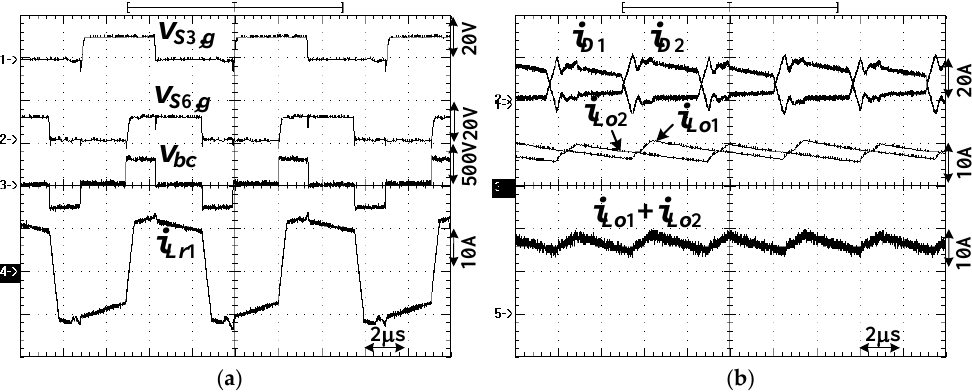
Figure 8. Test waveforms at V in = 290 V (low voltage input range) and P o = 800 W: ( a ) primary-side waveforms v S 3 ,g , v S 5 ,g , v bc , and i Lr 1 ; ( b ) secondary-side waveforms i D 1 , i D 2 , i Lo 1 , i Lo 2 , and i Lo 1 + i Lo 2 .